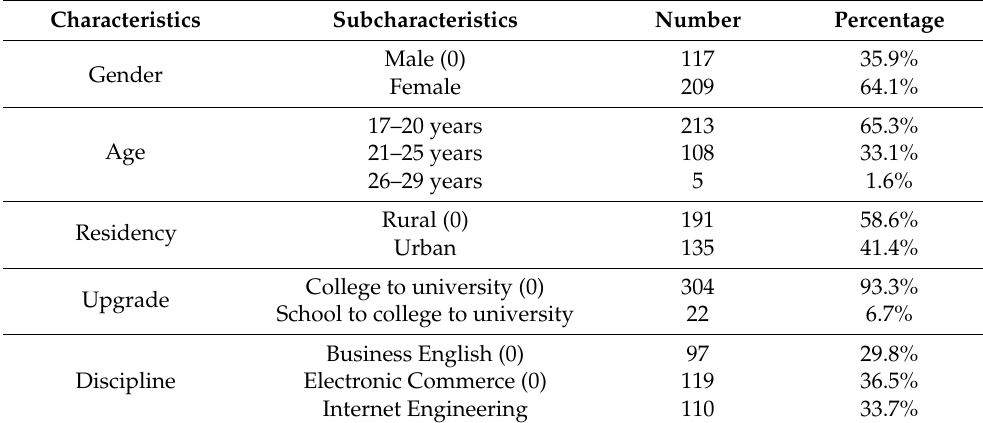
Table 1. Characteristics of the study